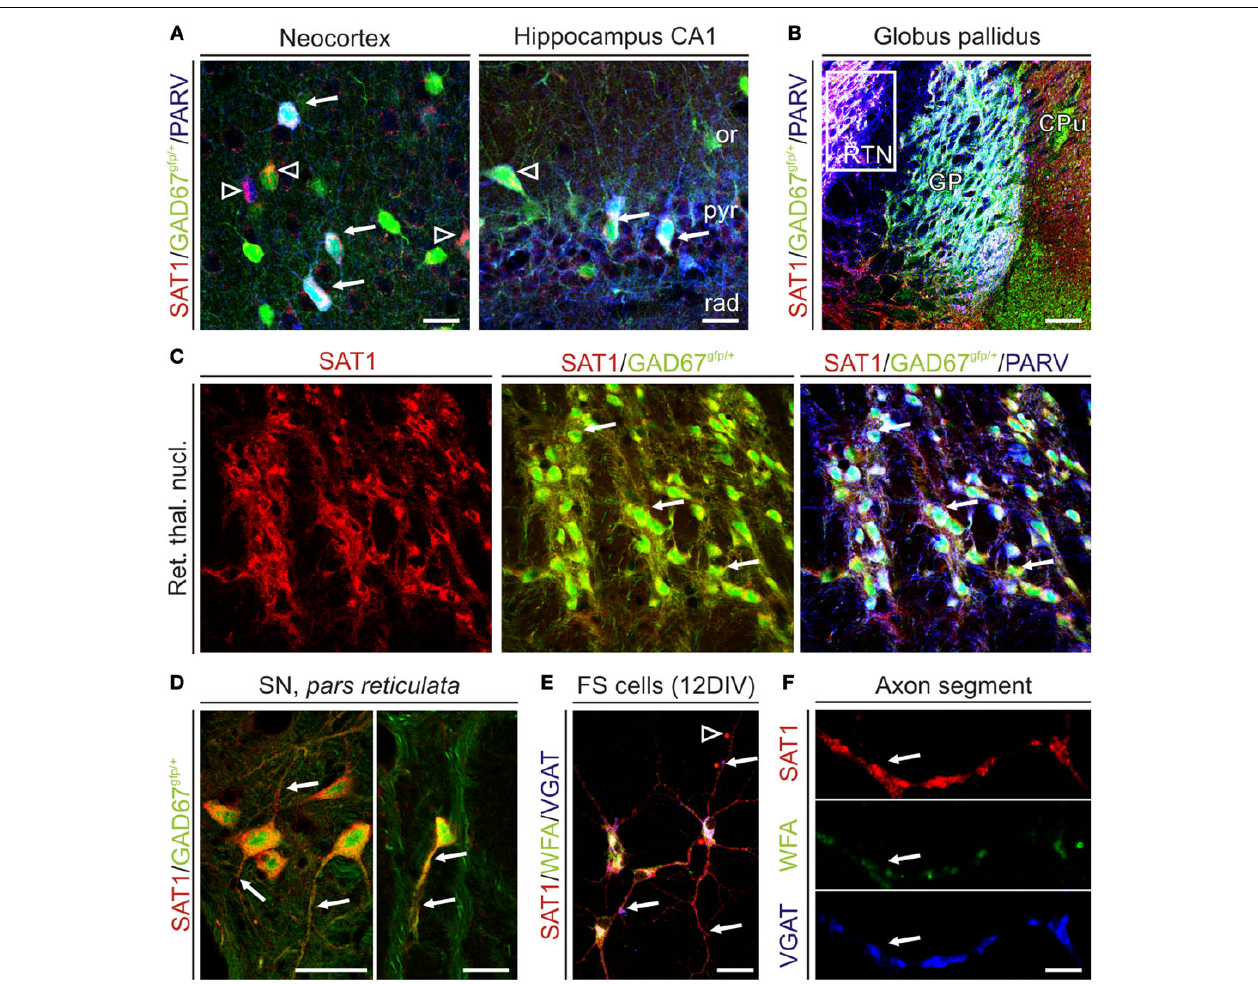
FIGURE 6 | SAT1 immunostaining is pronounced in GAD67/PARV + neurons and is targeted to VGAT containing axonal segments. Young adult mice heterozygously expressing green fl uorescence protein (GFP) knocked into the GAD67 locus were perfusion fi xed and immunofl uorescently labeled for SAT1 and cellular markers. (A) In the neocortex (L2/3) and hippocampus, SAT1 immunoreactivity accumulates in the somatodendritic domains of a subset of GABAergic interneurons also containing PARV ( arrows ). Arrowheads indicate SAT1/GAD67 gfp/ + -positive GABAergic interneurons that fall into other subclasses of interneurons. (B) Co-localization of SAT1 and PARV immunoreactivities in the basal ganglia. Tripled labelled neurons and their processes appear in white/light pink color. Note that virtually all PARV-containing neurons in the globus pallidus (GP) and reticular thalamic nucleus (RTN) express SAT1. Open rectangle